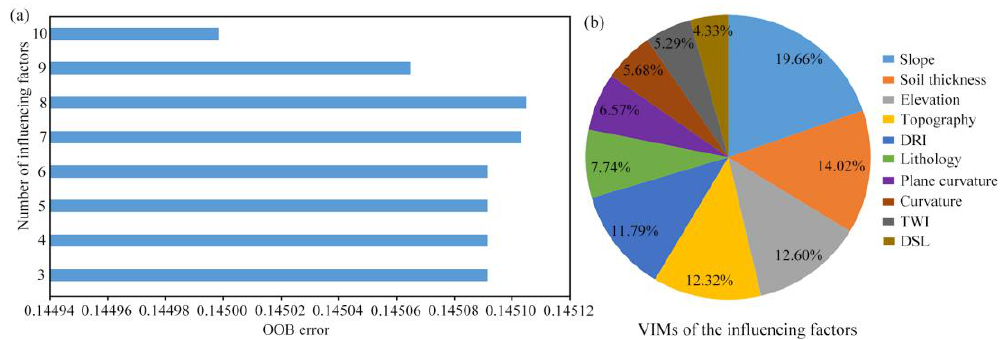
Figure 7. ( a ) Out-of-bag (OOB) errors of various factor selections and ( b ) variable importance measures (VIMs) of selected factors.